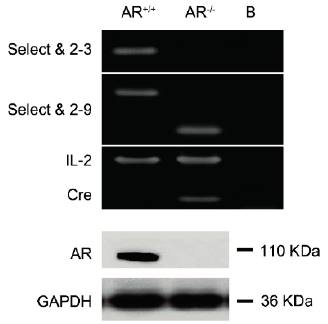
Figure 1. Genotyping of androgen receptor knockout ( AR − / − ) female mice. We used two pairs of primers (i) “select” and “2–3”; and (ii) “select” and “2–9” to identify AR wild